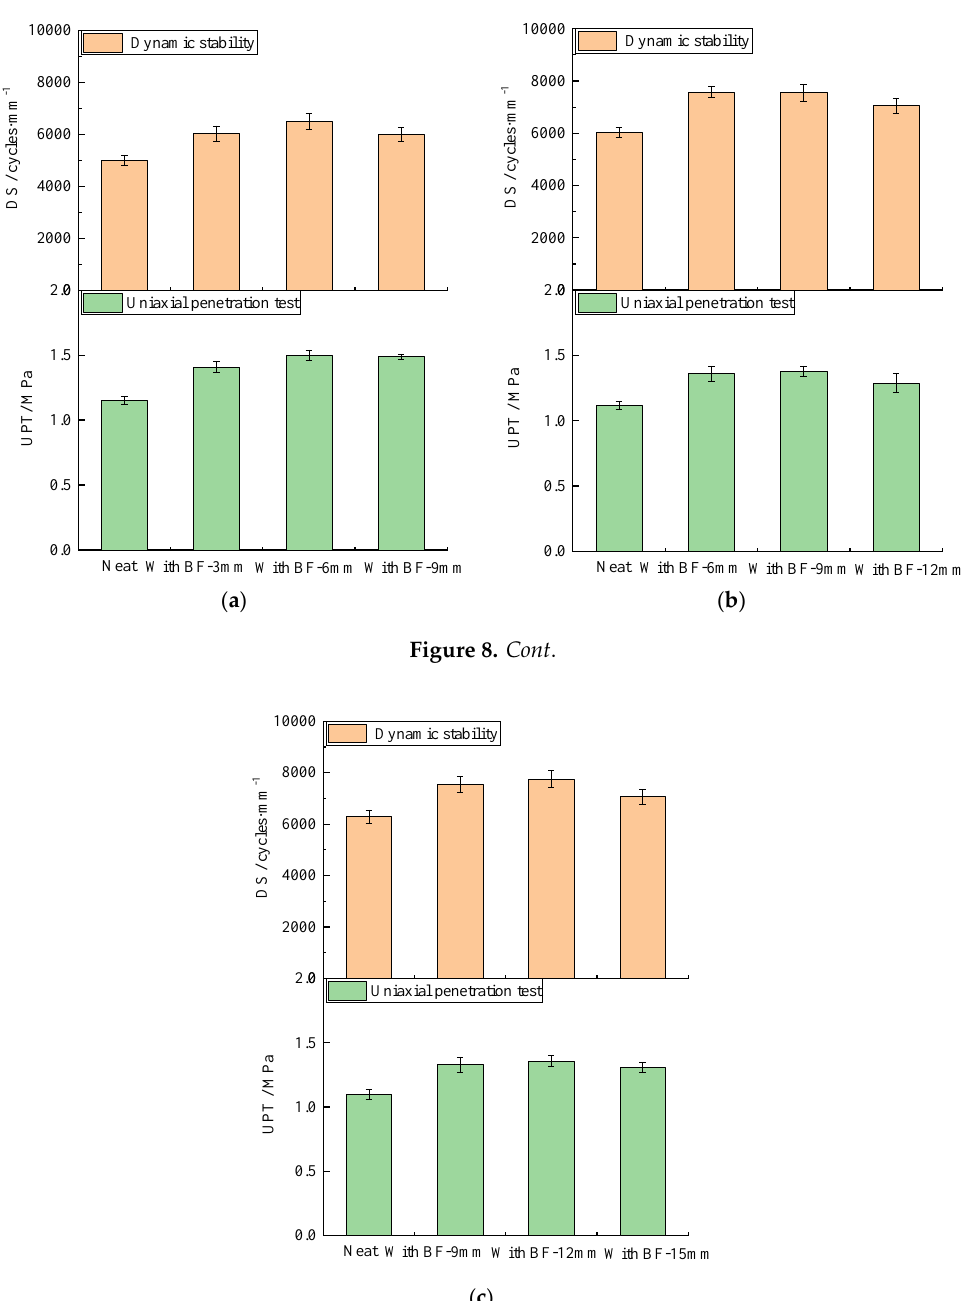
Figure 8. Wheel tracking and uniaxial penetration test (UPT) results: ( a ) SUP-13; ( b ) SUP-20; and ( c ) SUP-25.